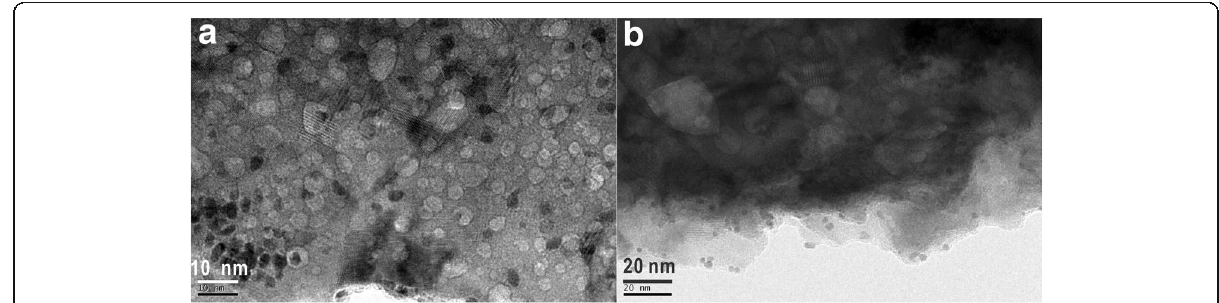
Fig. 4 a , b High-resolution TEM images of Pt nanoparticles supported on La 2 O 3 prepared by the ultrasonication-acoustic levitation method (metal concentration of 0.00625 g L − 1